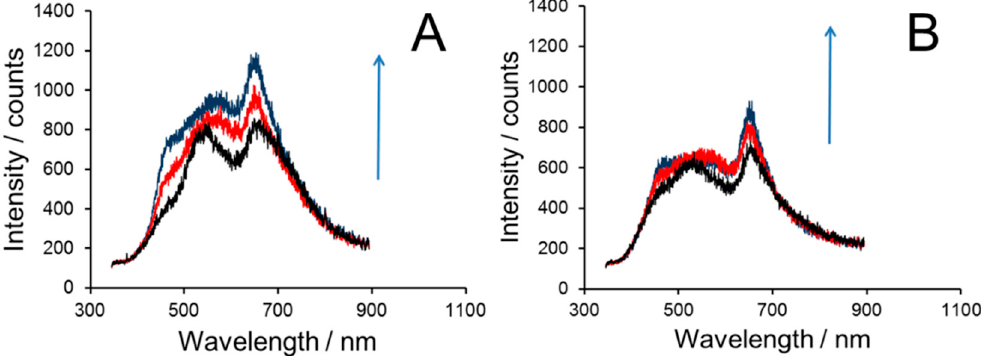
Figure 17. CL spectra taken at the initial state (black), after 60 s (red) and 180 s (blue). ( A ) Opaline matrix; ( B ) vessel region with chalcedony.